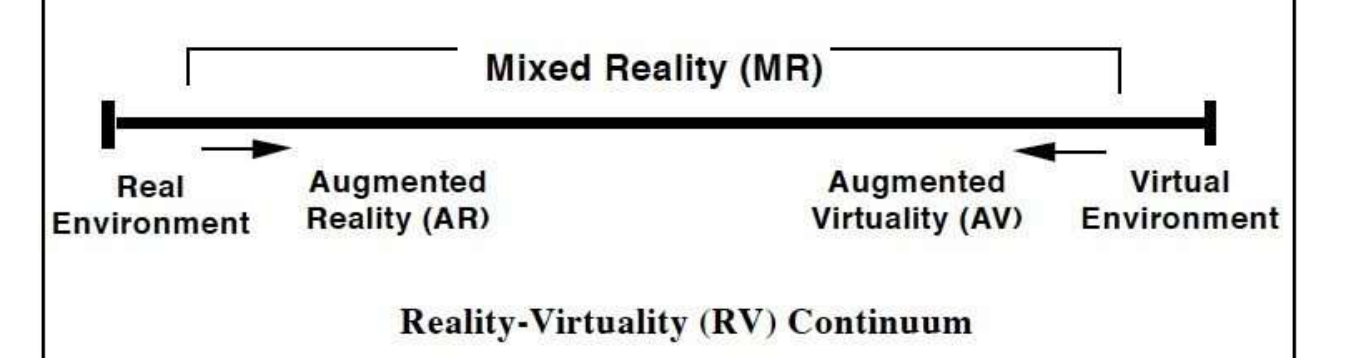
Figure 1. Reality–Virtuality [3].